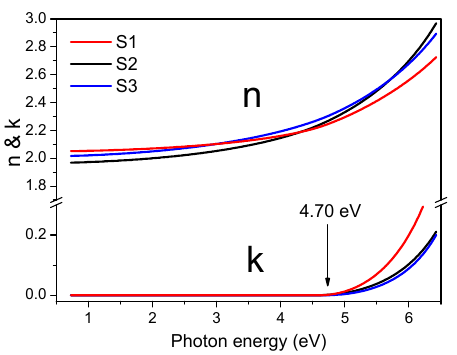
Figure 10. Optical constants of refractive indices (n) and extinction coefficients (k) for three HfO 2 films of S1, S2, and S3 at RT (300 K).